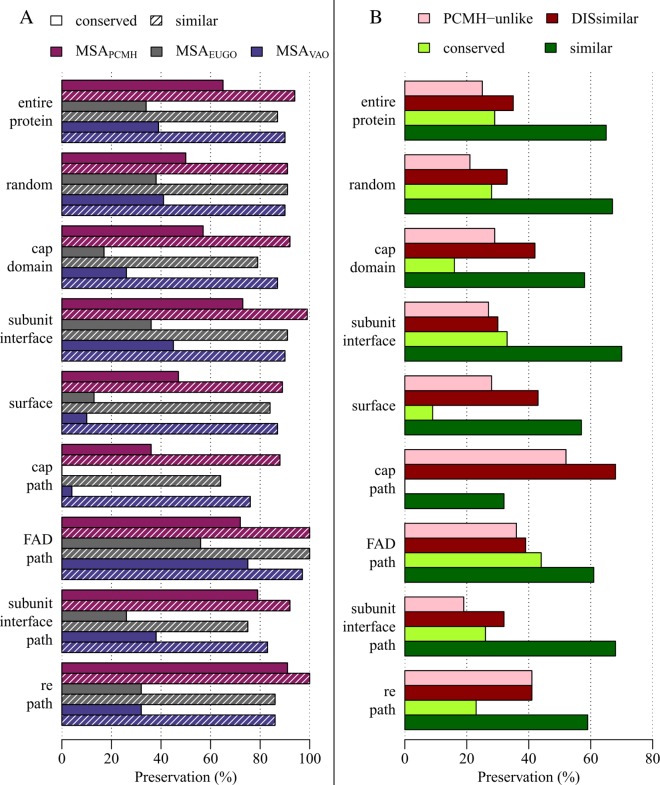
Sequence preservation of ligand migration paths.Preservation of residues in the entire protein, a random selection (random), the cap domain, the subunit interface, on the surface of the protein (surface), in the cap path, the FAD path, the subunit interface path and the re path. A: Sequence preservation of ligand migration paths within MSAVAO, MSAEUGO and MSAPCMH. B: Sequence preservation of ligand migration paths within MSAall.